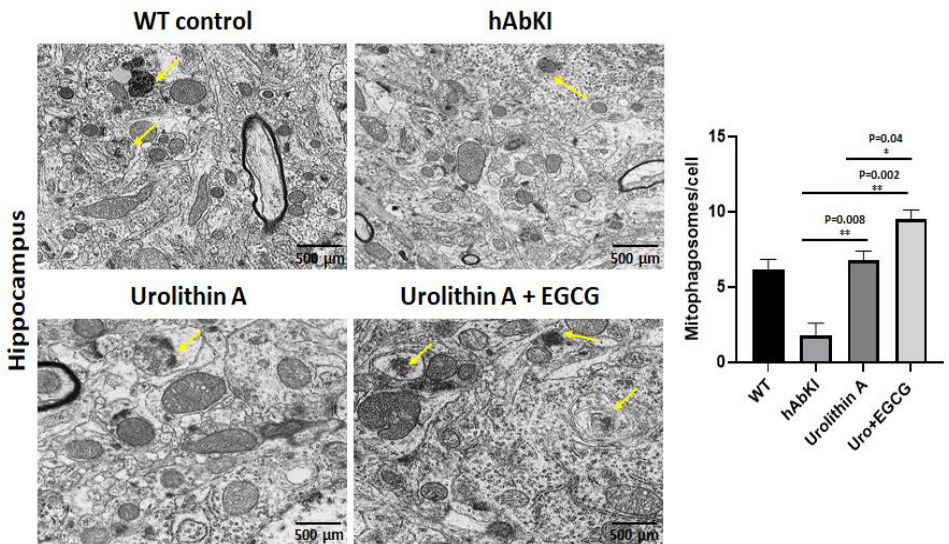
Figure 12. Transmission electron microscopy of cortical and hippocampal tissues from seven-month-old hAbKI mice and treated hAbKI mice with Urolithin A and EGCG. Using transmission electron microscopy, we assessed mitochondrial number and length in cortical and hippocampal tissues from seven-month-old hAbKI and treated hAbKI mice with Urolithin A and EGCG. ( A ) shows representative images of mitochondrial morphology in cortical and hippocampal areas of hAbKI and treated hAbKI mice brains. ( B ) shows significantly increased mitochondrial number in the cortices and hippocampi of hAbKI mice relative to treated hAbKI mice with Urolithin A and EGCG. Mitochondrial length is reduced in the cortices and hippocampi of hAbKI mice relative to treated hAbKI mice with Urolithin A and EGCG.